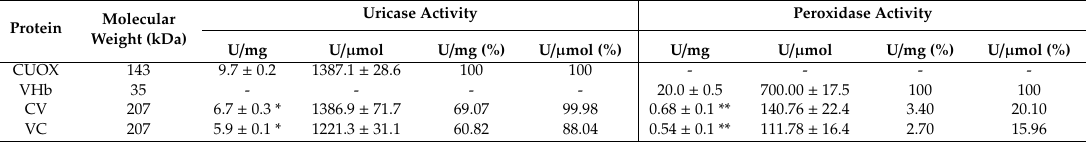
Figure 5. Effect of pH on ( a ) uricase and ( b ) peroxidase activities of native and fusion proteins. Enzymatic activities were assayed at 25 °C, under different pH conditions. Table 1. Molecular weight, specific and relative activity of the produced proteins.